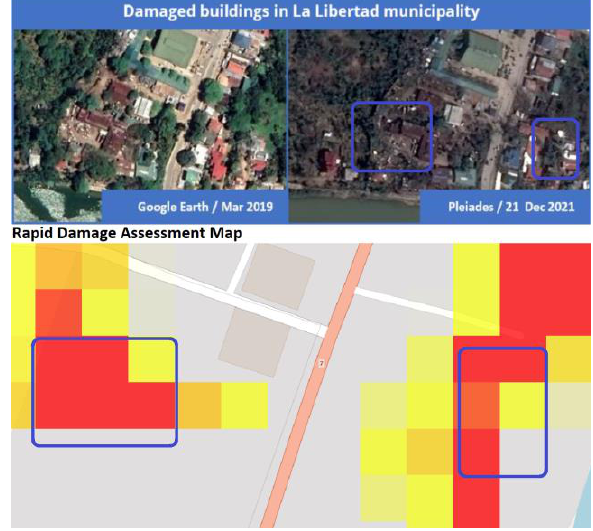
Figure 5. Rapid damage maps near La Libertad North Poblacion Primary School located in Negros Island. Bounding box indicates locations where potential damages have been identified in both optical and SAR images. Basemap © OSM 2022.